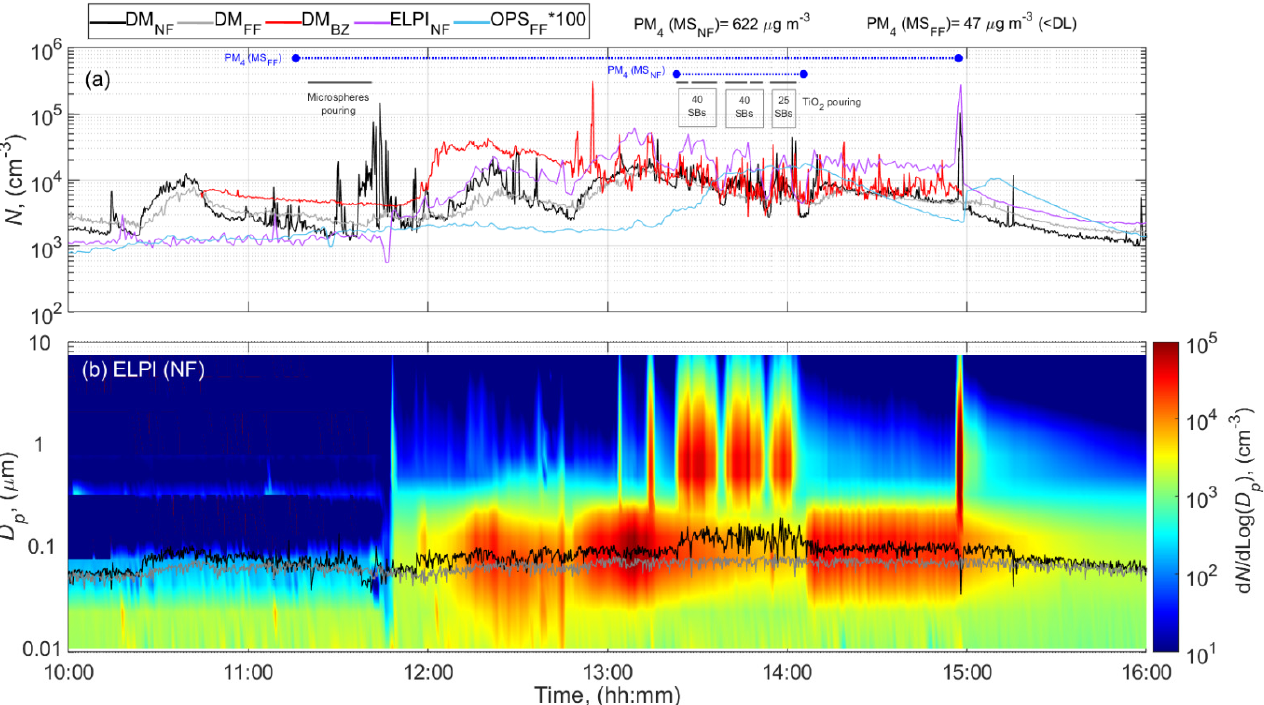
Figure 2. Time series during pouring activities involved in the paint formulation of batch #3 at the MS of ( a ) total particle number concentration, and ( b ) particle number size distributions measured by electrical low-pressure impactor (ELPI) at NF and mean particle size diameter measured by DM at NF and FF. The blue horizontal lines show the filter sampling periods.